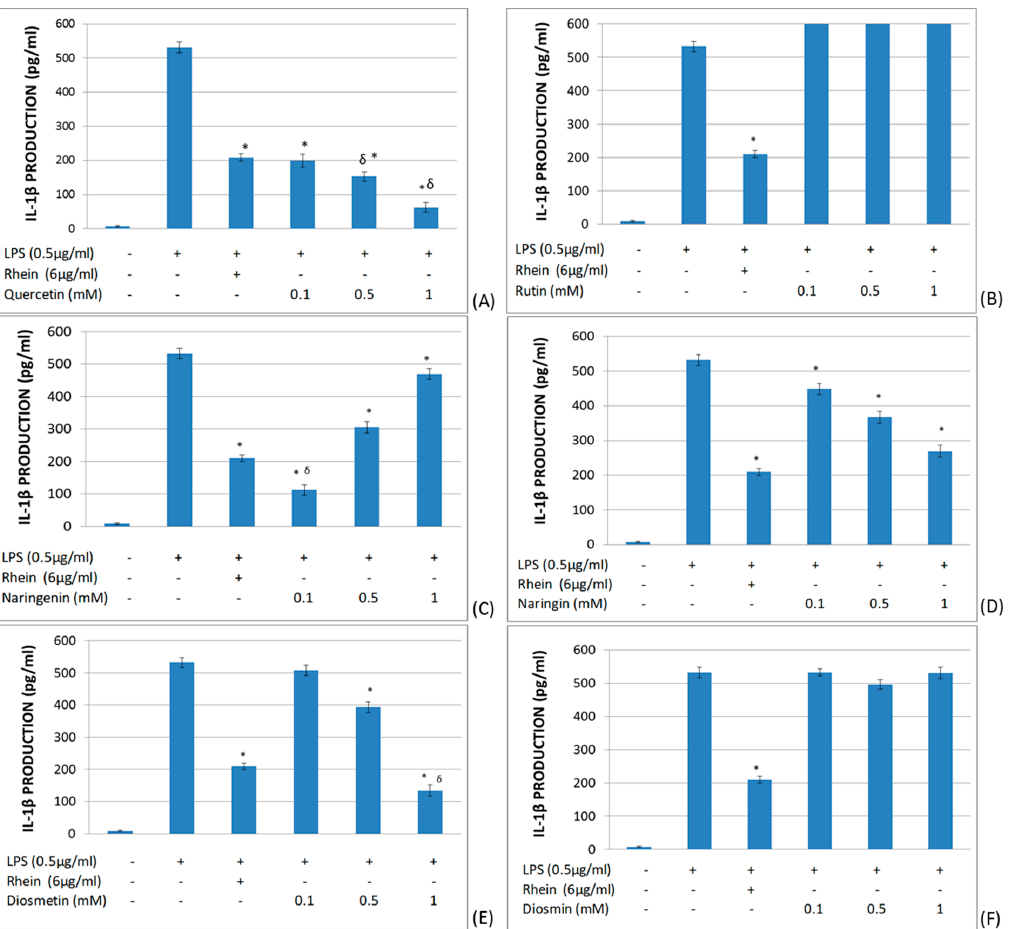
Figure 2. Effects of different flavonoids on the production of IL-1 β in LPS-stimulated (0.5 μ g/mL) whole blood after 6 h of culture. The different panels show the results of the effects of quercetin ( A ), rutin ( B ), naringenin ( C ), naringin ( D ), diosmetin ( E ), and diosmin ( F ). All data are expressed as the mean (top segment of the rectangles) ± SEM (vertical segment) of thirty independent experiments. * p < 0.05: significantly different when compared to the LPS control. δ p < 0.05: significantly different when compared to the rhein control.